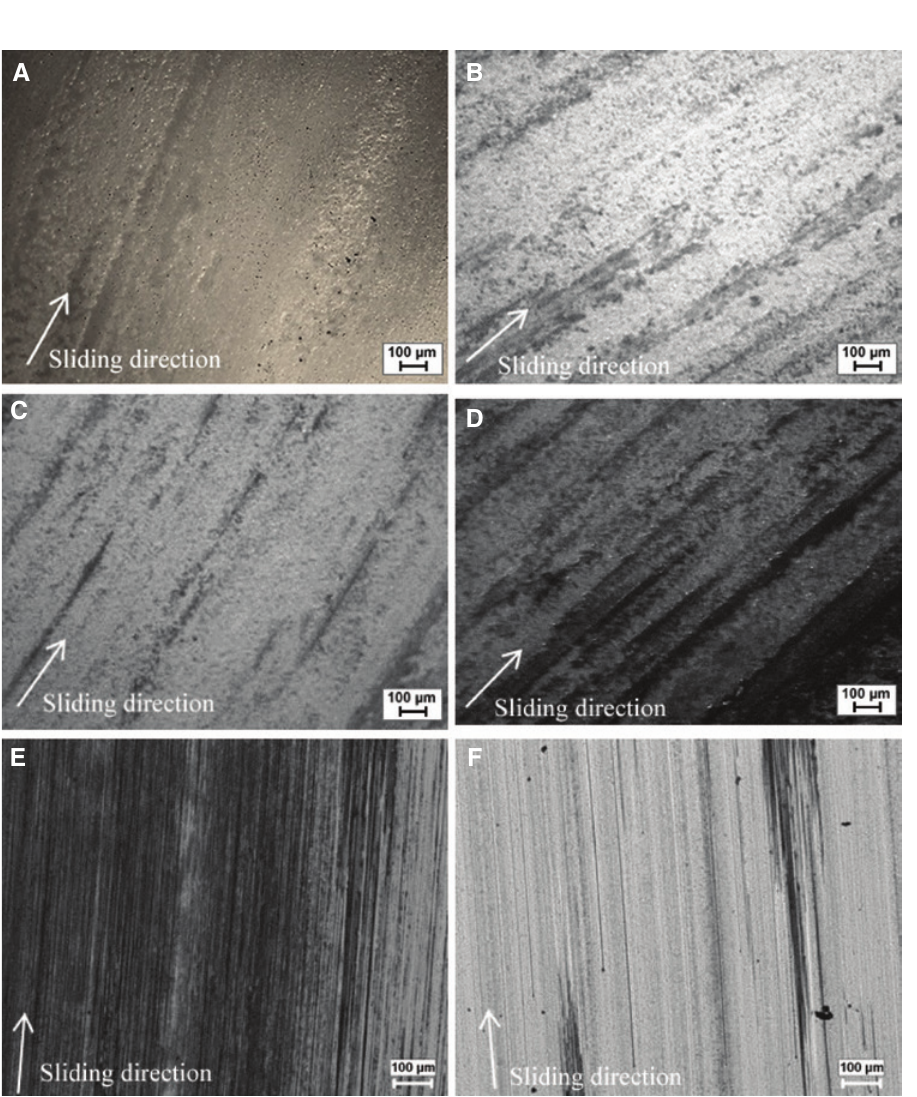
O epoxy composites at 0.4 m/s sliding speed and 15 N load conditions. 2 3 O -filled epoxy composite, (C) worn pin surface of 20 wt% Al 2 3 O -filled epoxy composite, (E) worn disc surface of pure epoxy, and (F) worn disc surface 2 3